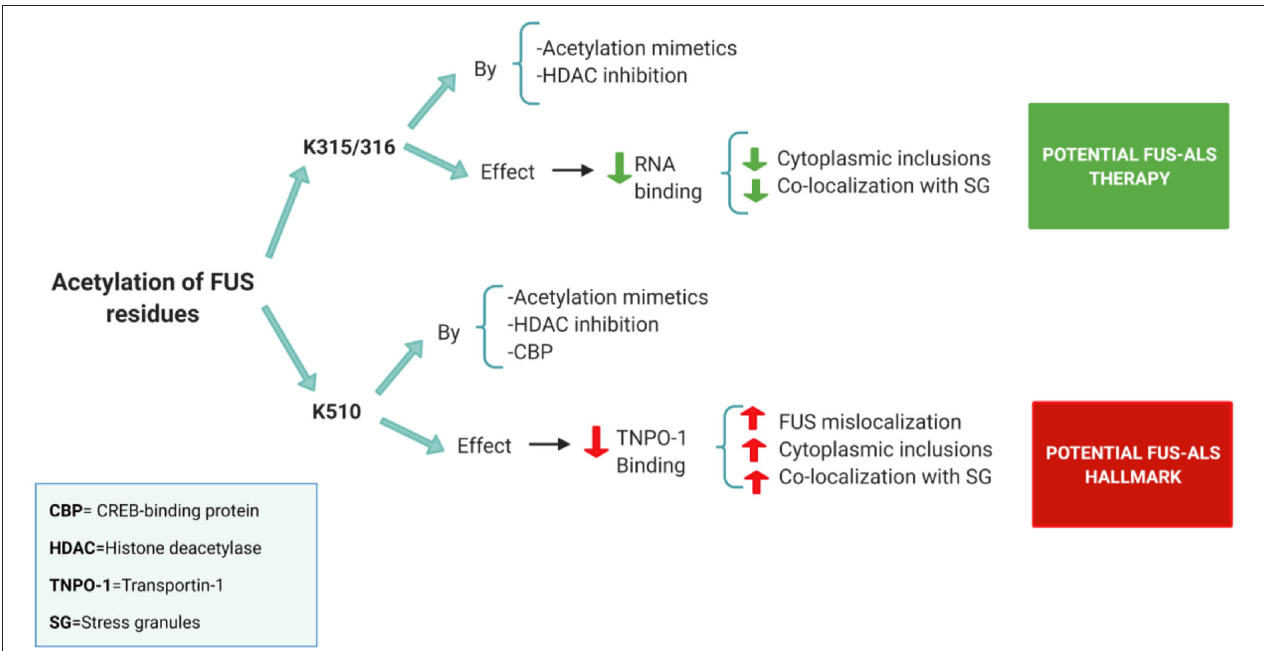
FIGURE 2 | Summary of the acetylation sites in FUS and its potential effects on FUS-ALS pathology [based on the results obtained in the study of Arenas et al. (2020)]. Acetylation of the FUS RRM (K315/316) by both acetylation mimetics and HDAC pan-inhibition (using a DACi cocktail) decreased FUS ability to bind to RNA. Prevention of RNA binding reduces cytoplasmic inclusions and FUS colocalization with stress granules. Thus, FUS acetylation on RRM sites has a positive effect on FUS-ALS pathology. On the other hand, FUS NLS region (K510 site) proved to be acetylated by acetylation mimetics, CBP or pan-HDAC inhibition. Acetylation of the K510 residue results in the loss of affinity with Transportin-1 leading to increased FUS mislocalization. Thus, FUS acetylation on the NLS site has a negative effect on FUS-ALS